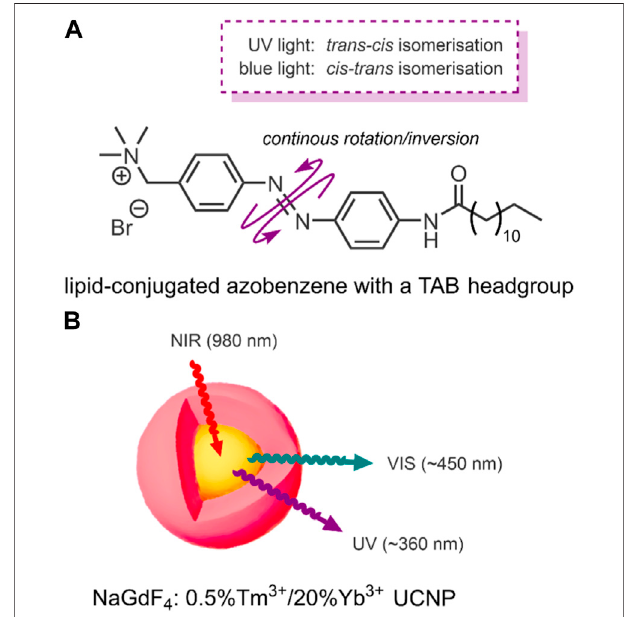
FIGURE 4 | (A) Amphiphilic lipid-conjugated azobenzene with a TAB headgroup. The switch undergoes a continuous rotation/inversion on irradiation with UV and VIS light (Yao et al., 2016). (B) NaGdF 4 : 0.5%Tm 3+ / 20%Yb 3+ core-shell (highlighted yellow-red) UCNPs upconvert 980 nm NIR light into ~360 nm UV and ~450 nm VIS light (Yao et al.,